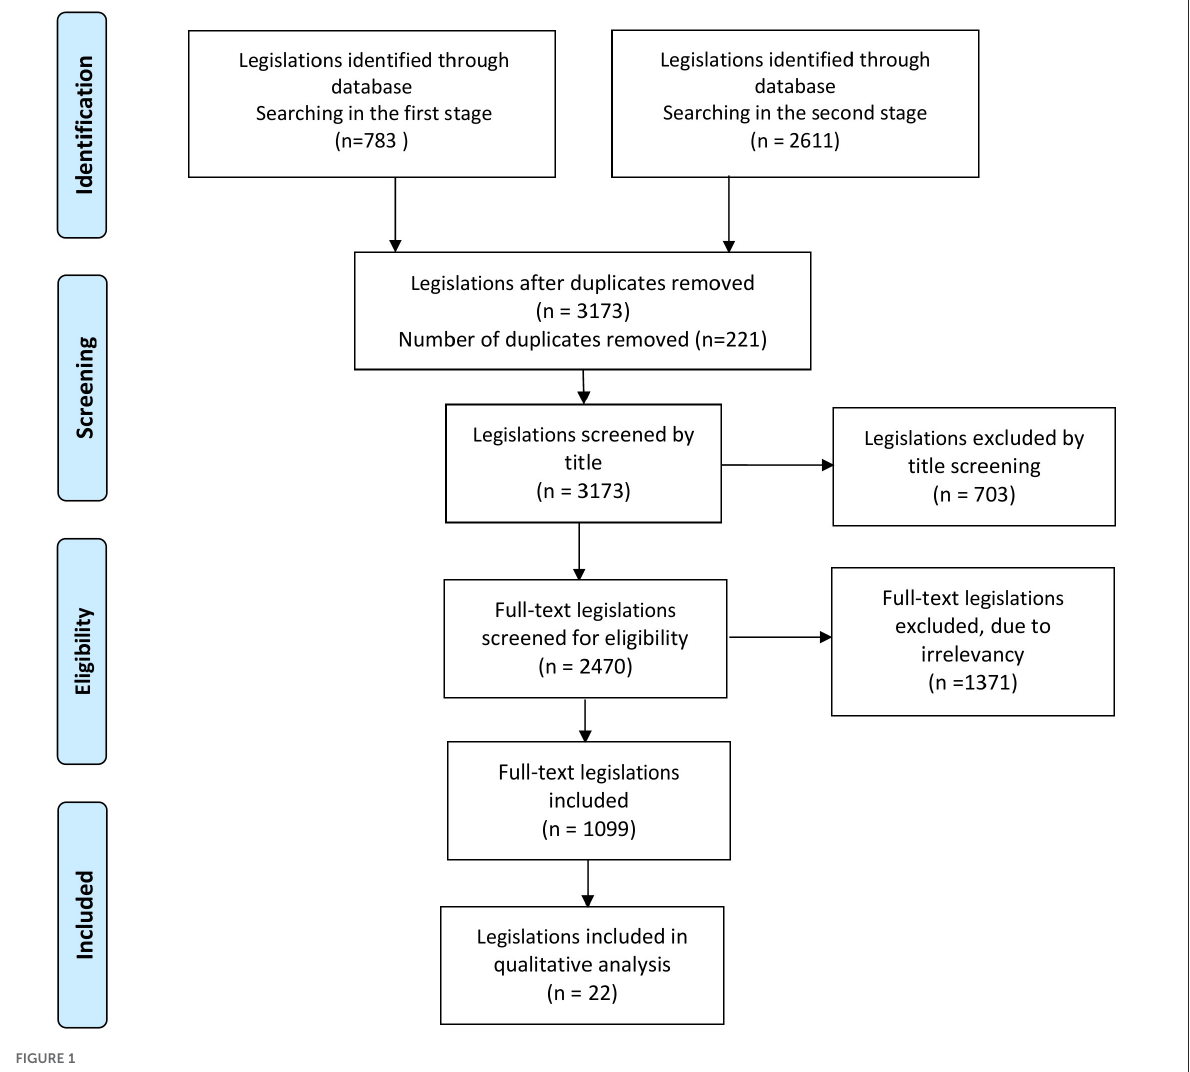
FIGURE1 Selection process of EU